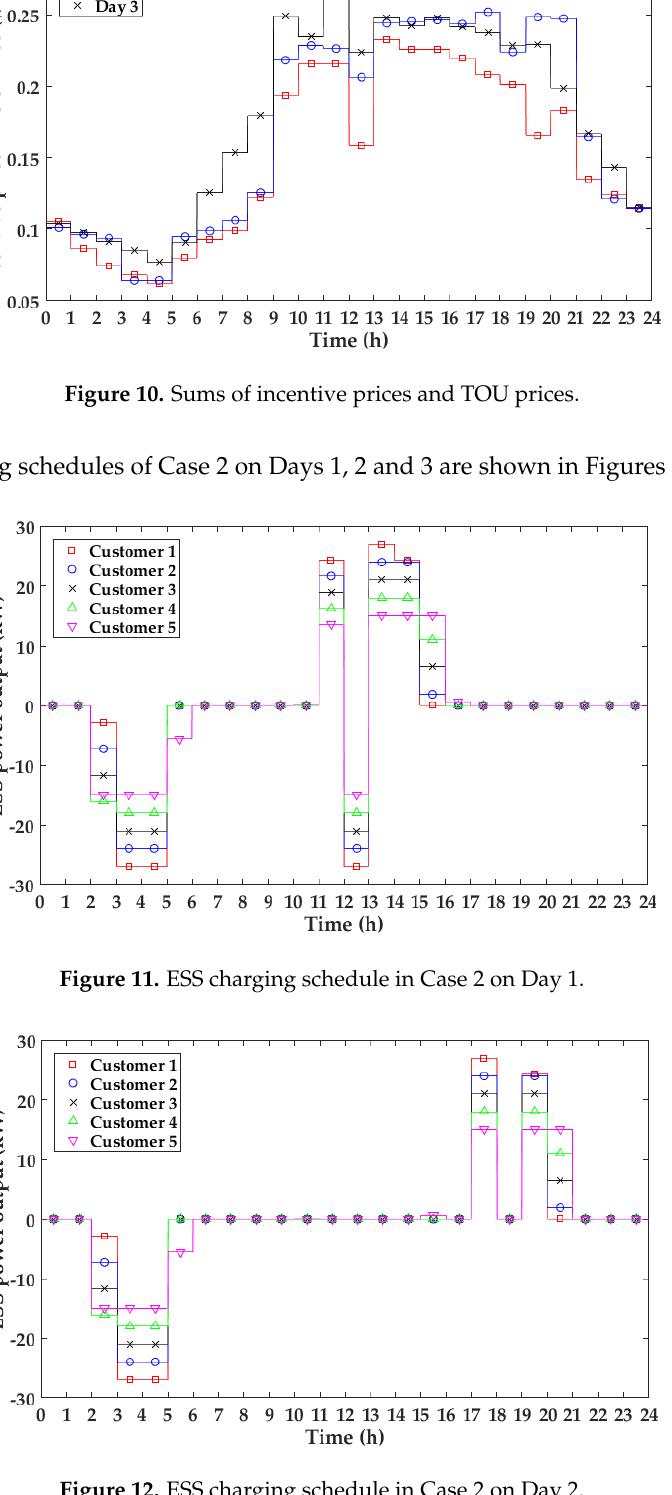
Figure 9. Incentive prices in Cases 2 and 3.